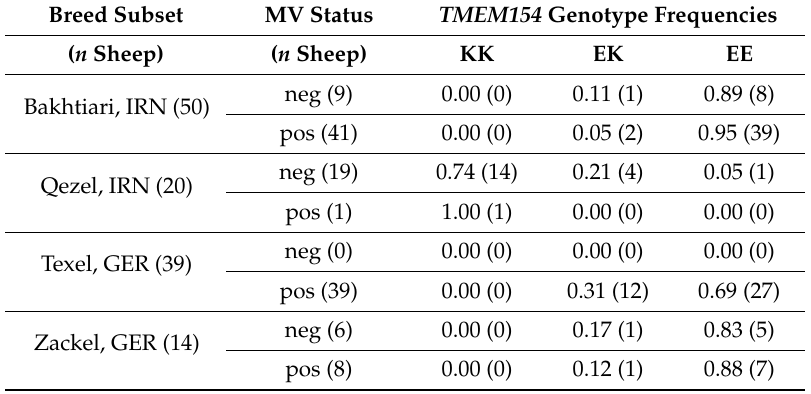
Table A3. Genotyping results of TMEM154 E35K variants in four positive sheep flocks of Iran (IRN) and Germany